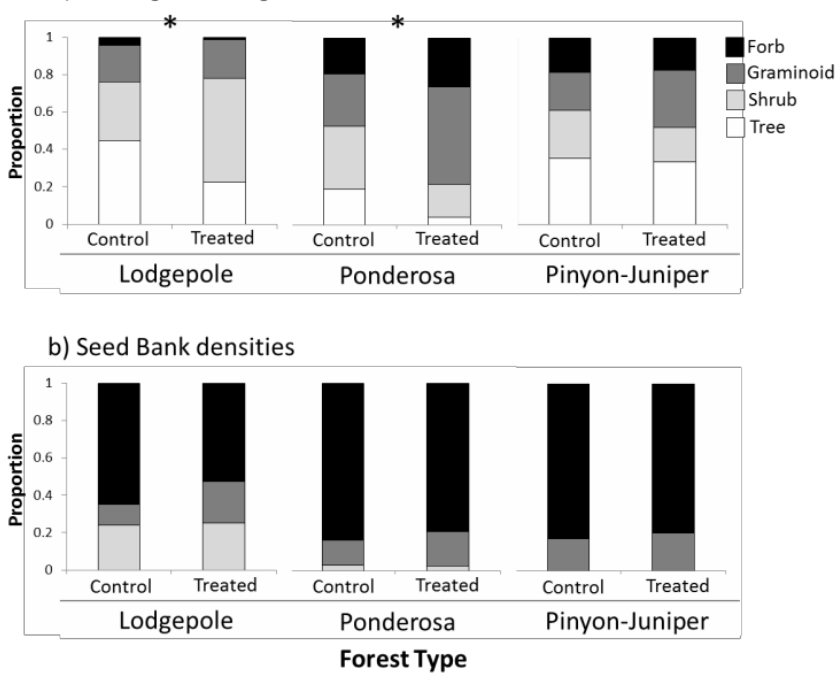
Figure 2. Proportions of plant functional groups of the ( a ) aboveground vegetation cover and ( b ) seed bank densities. Asterisks indicate significant differences ( p < 0.05)